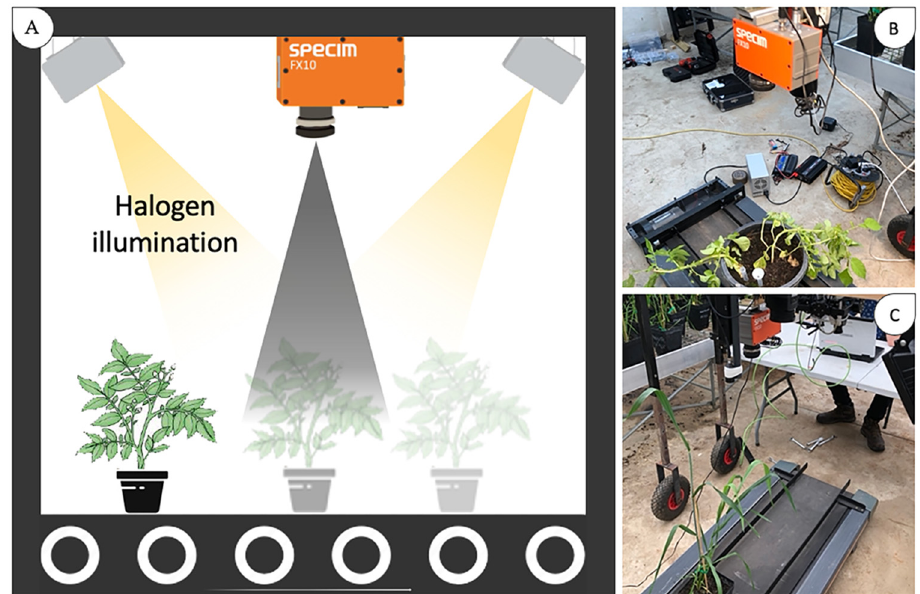
Figure 1. Schematic diagram of the hyperspectral imaging system with a conveyor belt and two halogen light sources for measuring plants ( A ), potted potato ( B ), and potted wheat ( C ) plants being measured with the hyperspectral camera.